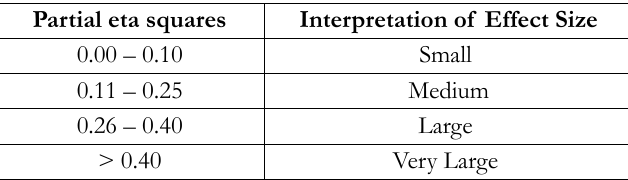
Table 4. Interpretation of partial eta squared